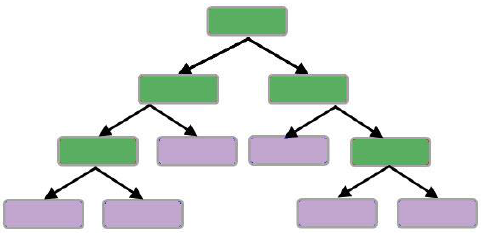
Figure 2. Schematic diagram of the DT classifier (nodes and leaves are colored green and purple, respectively). respectively).